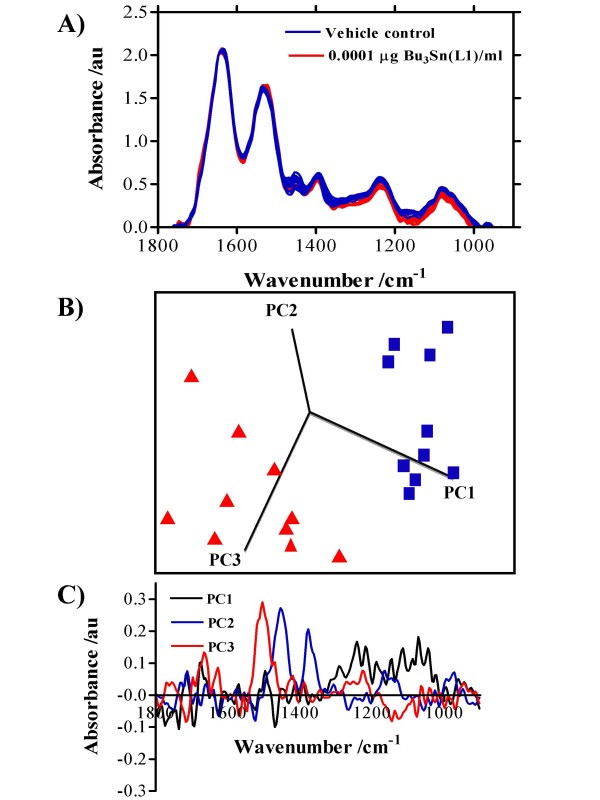
Average IR spectra of MCF-7 cells with corresponding scores plots plotted on PCs 1, 2 and 3 and loadings plots following 24-h exposure to 0.0001 μg Bu3Sn(L1)/ml. Cells were seeded into 60-mm Petri dishes and allowed to attach for 24 h prior to exposure. Following exposure, cells were disaggregated with trypsin/EDTA solution, fixed in 70% EtOH, and applied to Low-E Microscope slides whereupon the suspensions were allowed to air-dry. A) 10 IR spectra were derived (vehicle control in blue, treated in red). B) From subsequent multivariate analysis, a 3-D scores plot on PCs selected to demonstrate best segregation of vehicle control (blue) vs. exposure (red) was constructed. C) Following cluster analysis, loadings plots were constructed on each relevant PC to identify the wavenumbers most responsible for segregation of clusters.